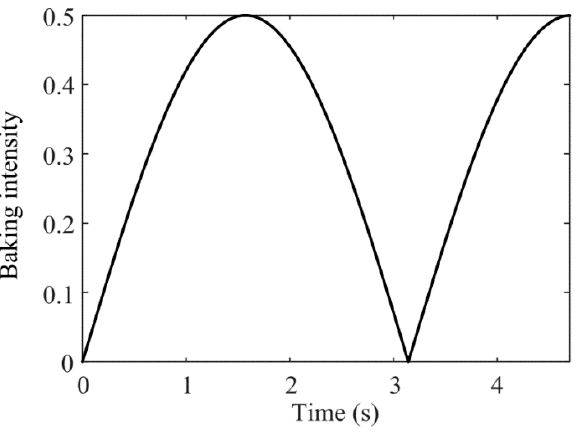
Figure 3. Vehicle braking condition.